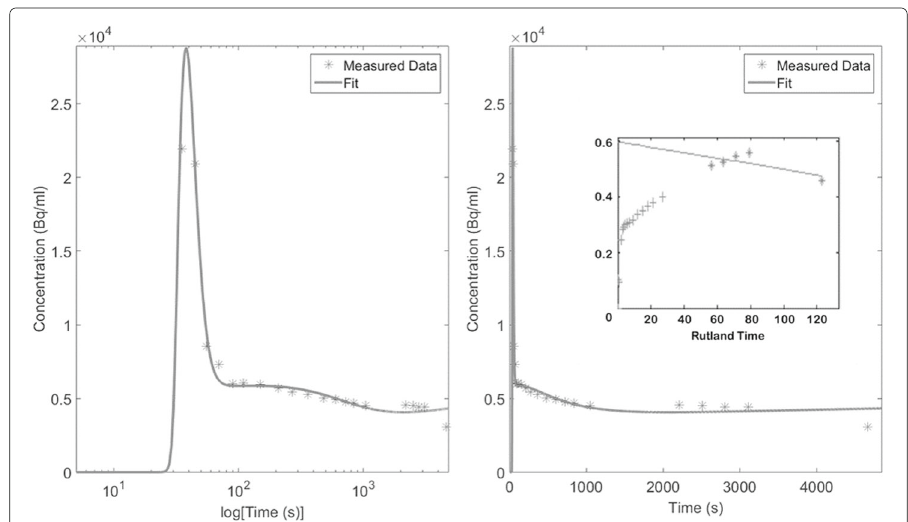
Fig. 3 Example patient TTAC and fits with conventional analysis measured patient TTAC (stars) and the associated compartment model and Patlak-Rutland (inset to column 2) fits (filled line). Both columns show the same data. However, the left column has the x -axis in log(time) to allow better visualisation of the peak, while in the second column, the x -axis is linear in time